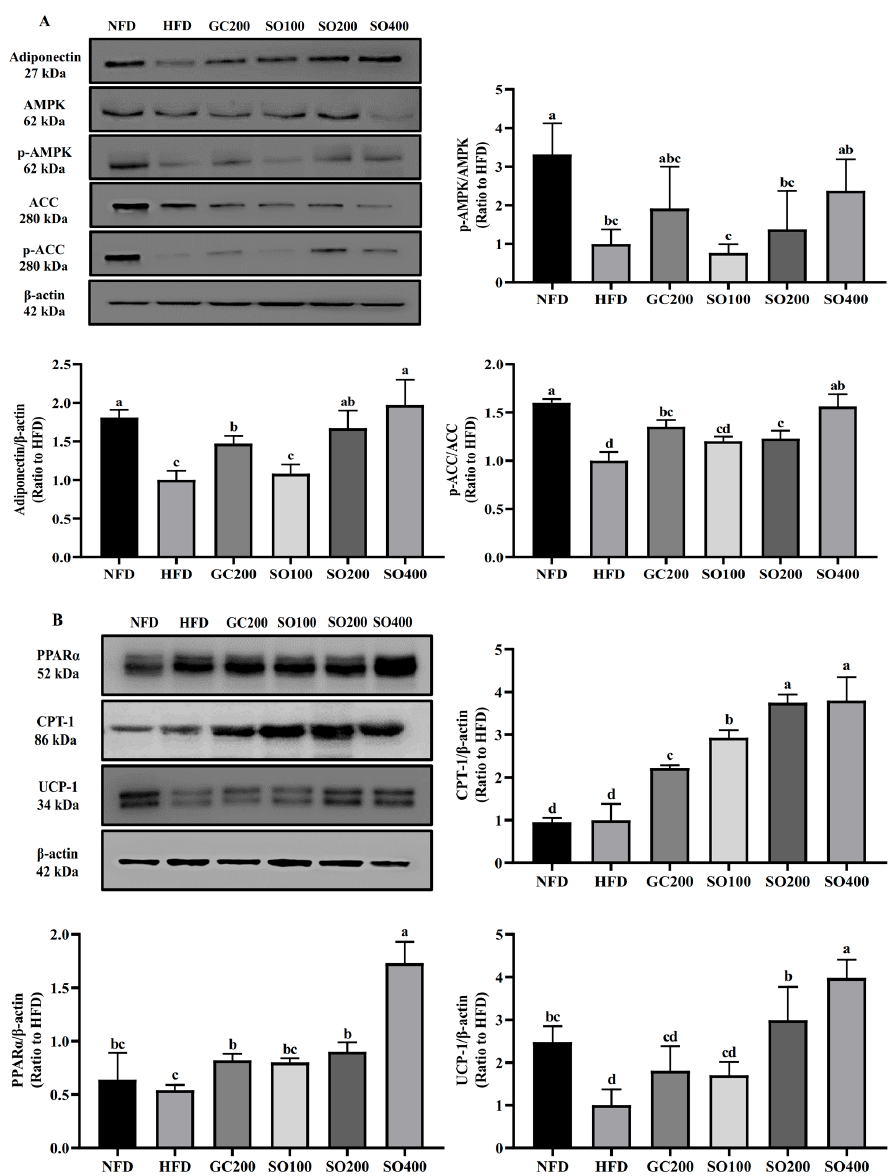
Figure 9. Effects of SO on energy metabolism and thermogenesis in WAT of HFD-induced obese mice: ( A ) adiponectin and AMPK pathways; ( B ) thermogenesis-related factors. GC200, HFD